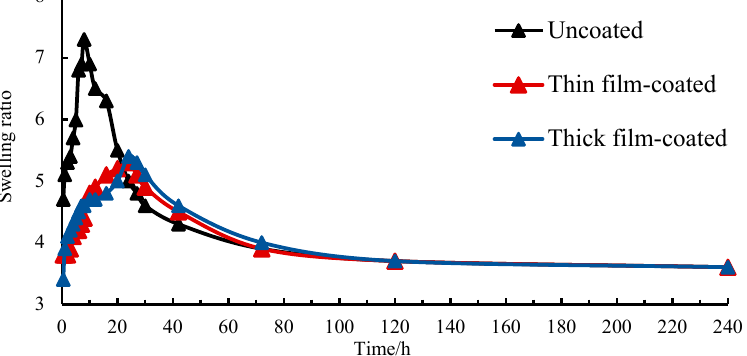
Figure 5. Swelling performance evaluation test of film-coated XN-T.